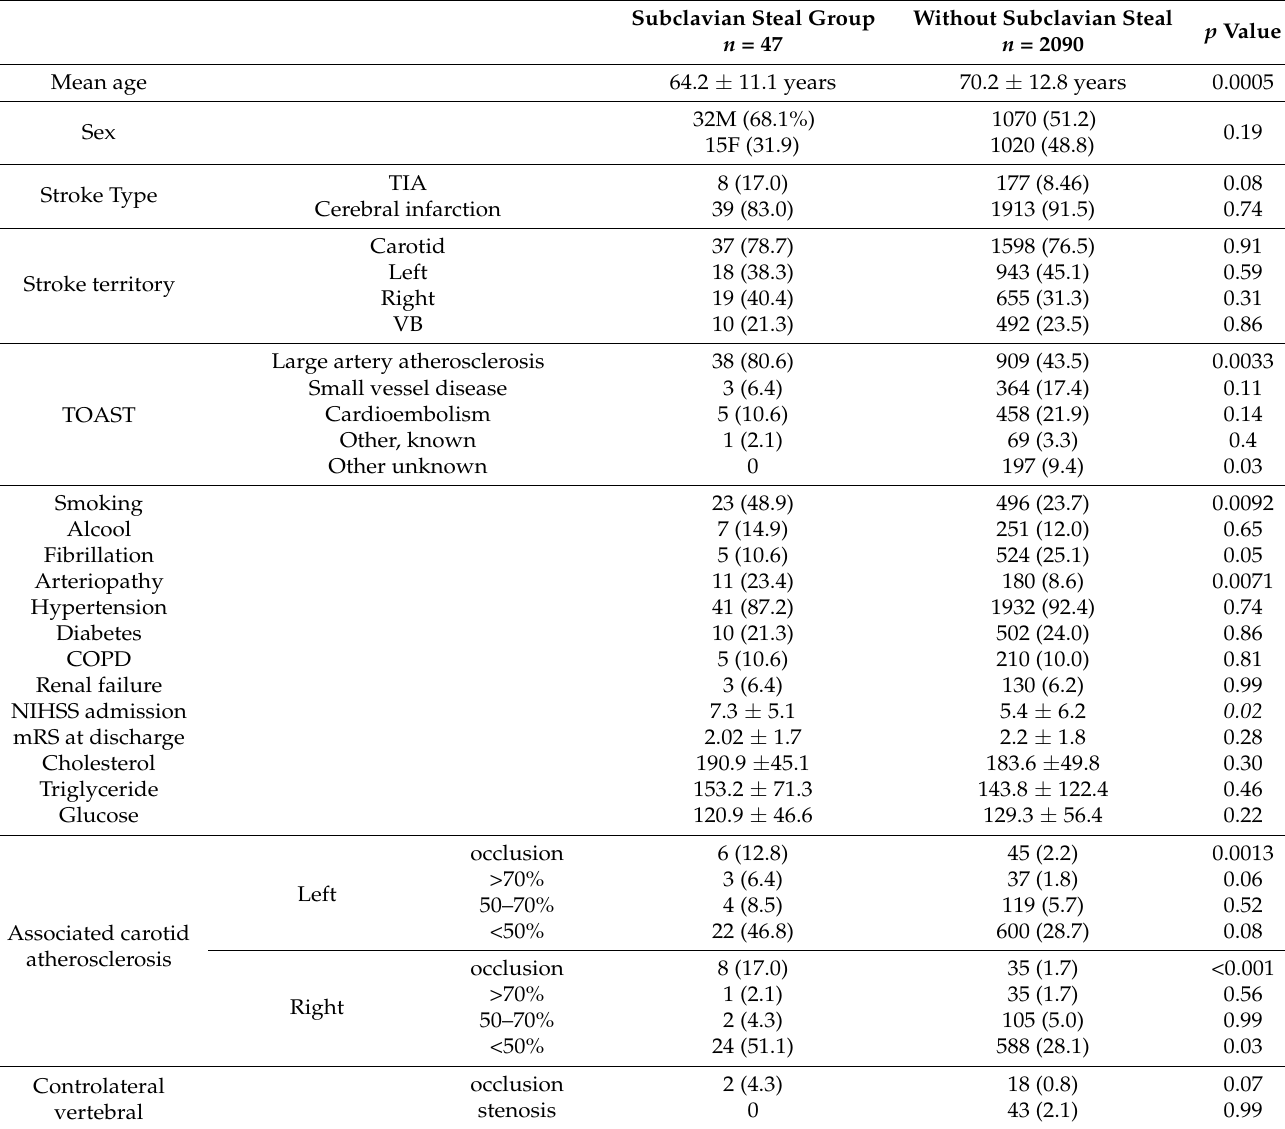
Table 1. The main demographical and clinical characteristics of the stroke groups with and without the associated subclavian steal